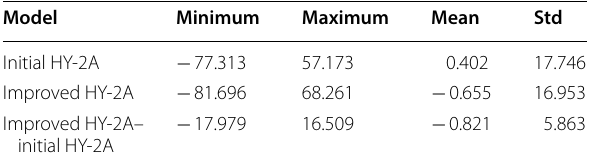
Table 5 Statistics about the variances and co-variances of vertical deflection errors